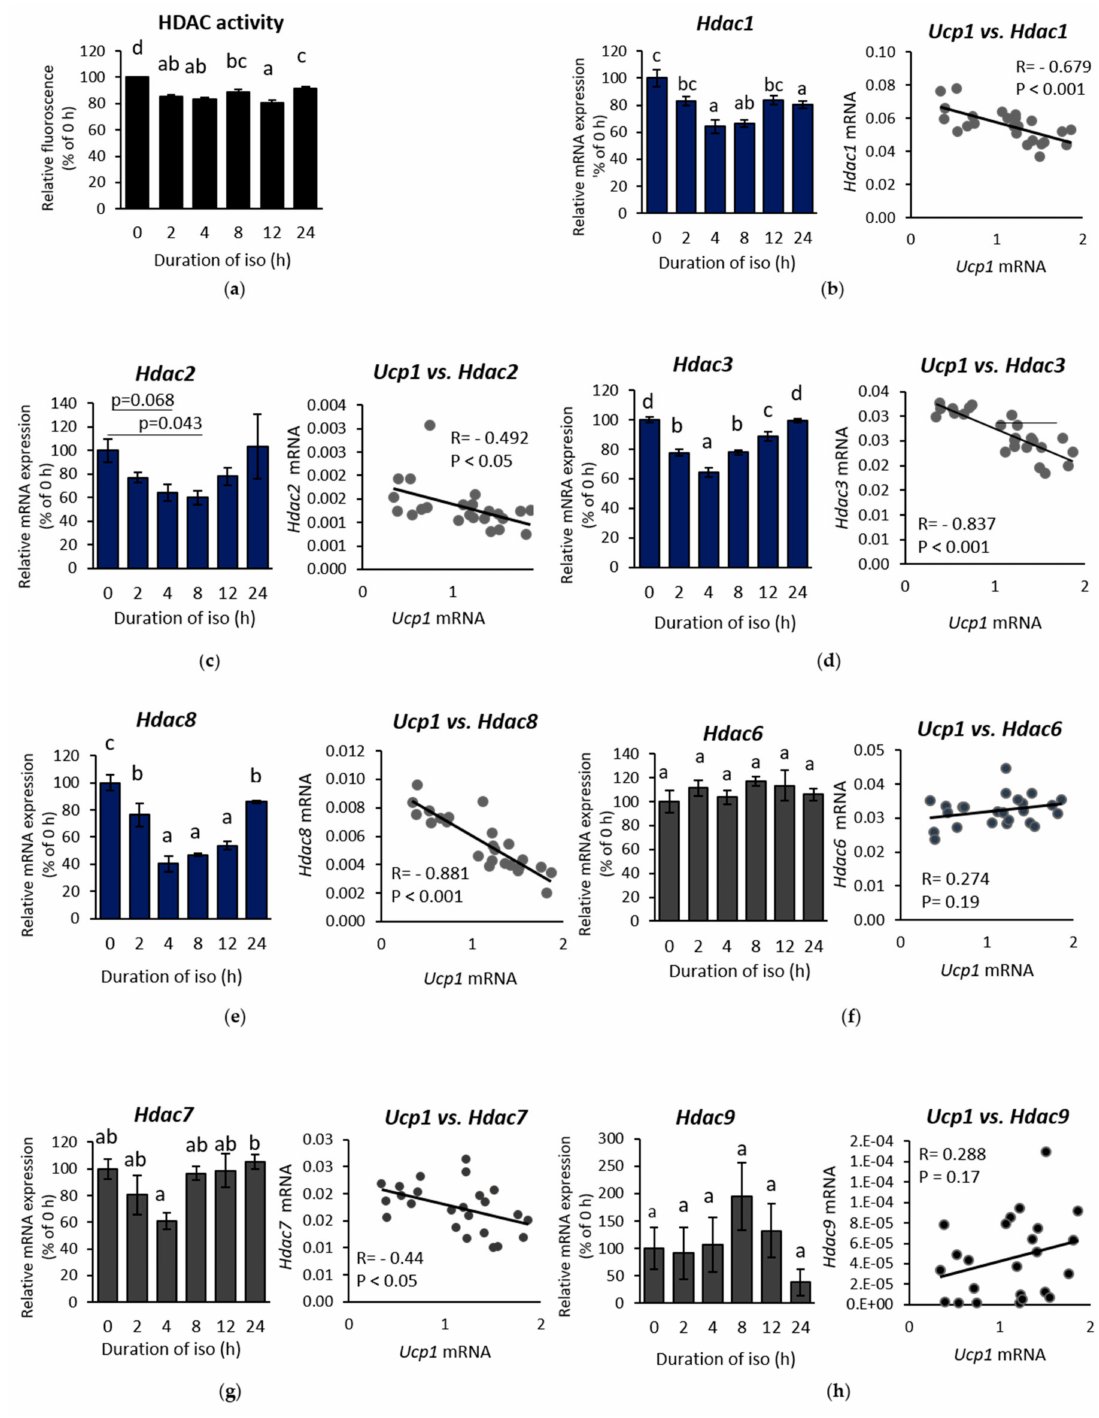
Figure 3. β -AR stimulation regulates histone deacetylase (HDAC) expression in IWAT cell. ( a ) HDAC activity, class I HDAC mRNA: ( b ) Hdac1 , ( c ) Hdac2 , ( d ) Hdac3 , and ( e ) Hdac8 ; and class II HDAC mRNA: ( f ) Hdac6 ( g ) Hdac7 , and ( h ) Hdac9 expression after induction by 10 µ M iso in a time-course experiment. HDAC mRNA expression (left side) and its association with Ucp1 (right side) based on Pearson’s correlation. Data are presented as mean ± S.E.M. (error bars). n = 4–8 in each group. Different letters indicate significant differences ( p < 0.05) according to one-way ANOVA followed by the Tukey-Kramer multiple comparison test. Same letters indicate non-significant